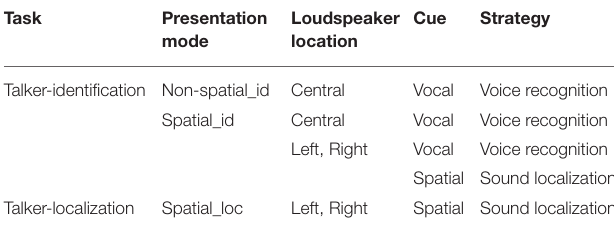
TABLE 1 | Experiment